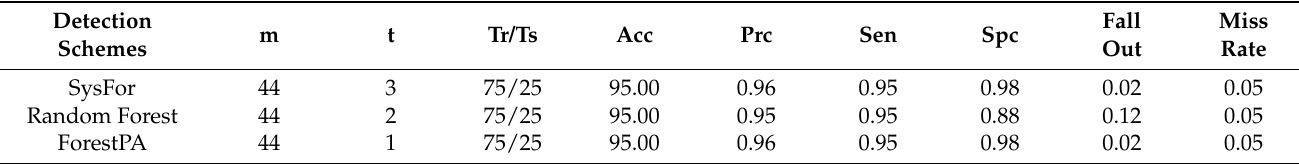
Table 12. Maximum performance received for decision forests with minimum number of decision trees on all feature segments of Spanish acoustic dataset.